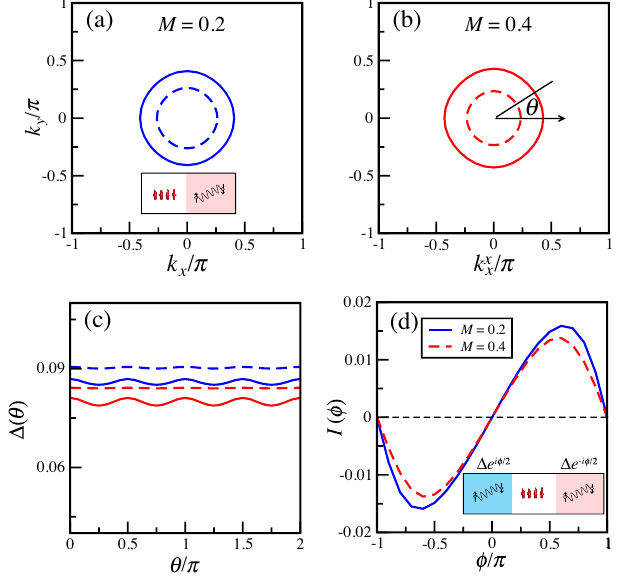
FIG. 5. (a) Fermi surface for TB with M ¼ 0 . 2 . The inset illustrates the proximity process leading to the pairing amplitude in (c). (b) Fermi surface for TB with M ¼ 0 . 4 . (c) Spin-singlet pairing strengths along each FS for M ¼ 0 . 2 , 0.4. θ is the angle along each FS as defined in (a) and (b). (d) The Josephson currents I ð ϕ Þ in unit of 2 e= ℏ for the magnetic JD for M ¼ 0 . 2 and M ¼ 0 . 4 , and the inset shows the setup for calculating the current. The other parameters are set as t R ¼ t L ¼ 1 . 0 , Δ 1 ¼ Δ 2 ¼ 0 . 2 , t ¼ 0 . 8 , t ¼ 0 . 6 , α ¼ 0 . 2 , μ ¼ − 3 . 0 . In the calculation, we RB LB set the thickness of SC on both sides to be